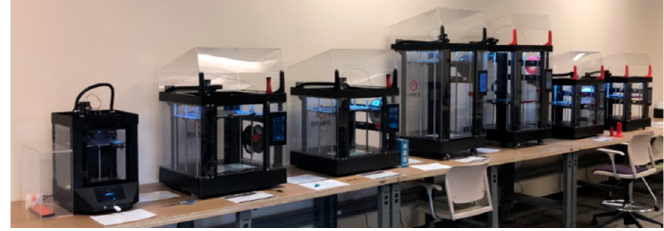
Figure 3. 3D printing (3DP) section of iMakerSpace .